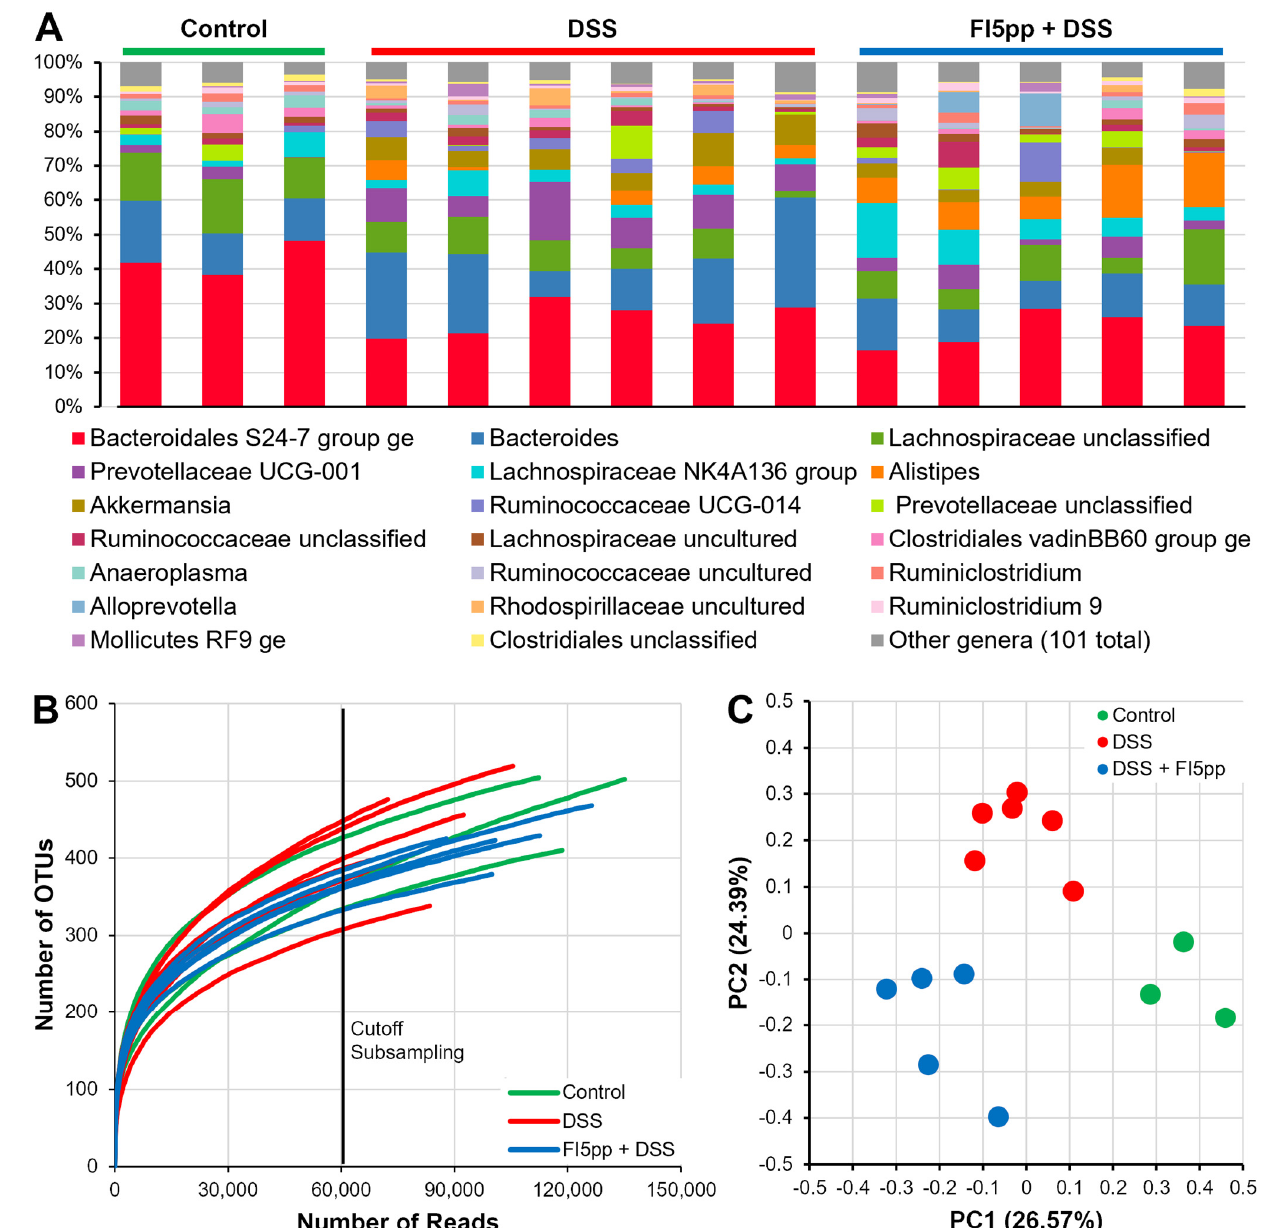
Figure 4. Comparison of the murine fecal microbiome of “Control”, “DSS” and “FI5pp + DSS” groups. Cumulative bar charts of the relative abundance for the top 20 genera found in the 14 mice stool samples. Genera not in the top 20 by relative abundance are categorized as other genera (101 in total) ( A ). Rarefaction curve based on the number of observed OTUs in the 14 samples. Black line indicates the subsampling cutoff used ( B ). PCoA of Bray-Curtis dissimilarity for “Control”, “DSS” and “FI5pp + DSS” groups ( C ).